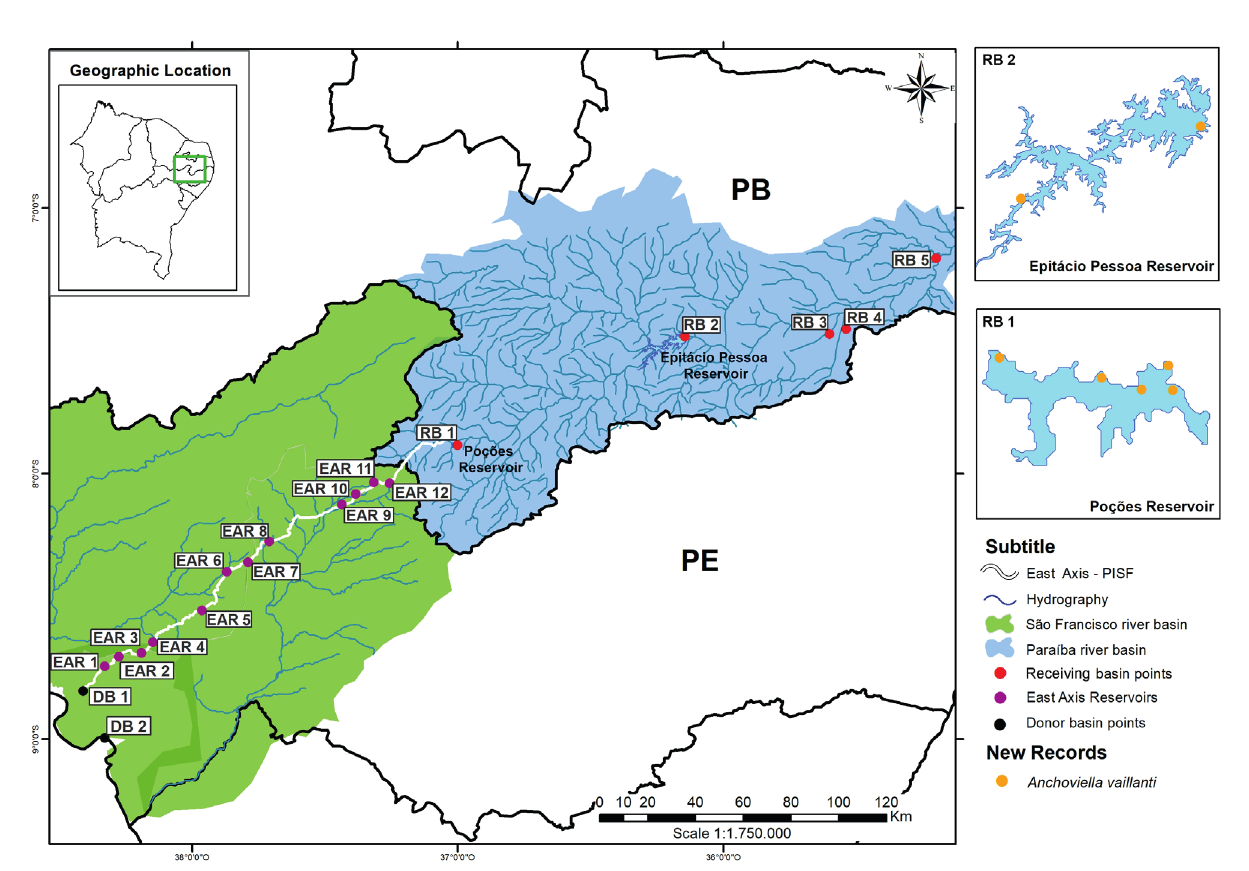
FIGURE 1 | Schematic representation containing the monitored sites along the East Axis of the São Francisco River Integration Project (SF- IWT) and the exact location of the new records of Anchoviella vaillanti in the Poções and Epitácio Pessoa Reservoirs. DB = Donor basin, EAR = East Axis Reservoirs, RB = Receiving basin. Detailed location list of the sampling sites in Tab. S1